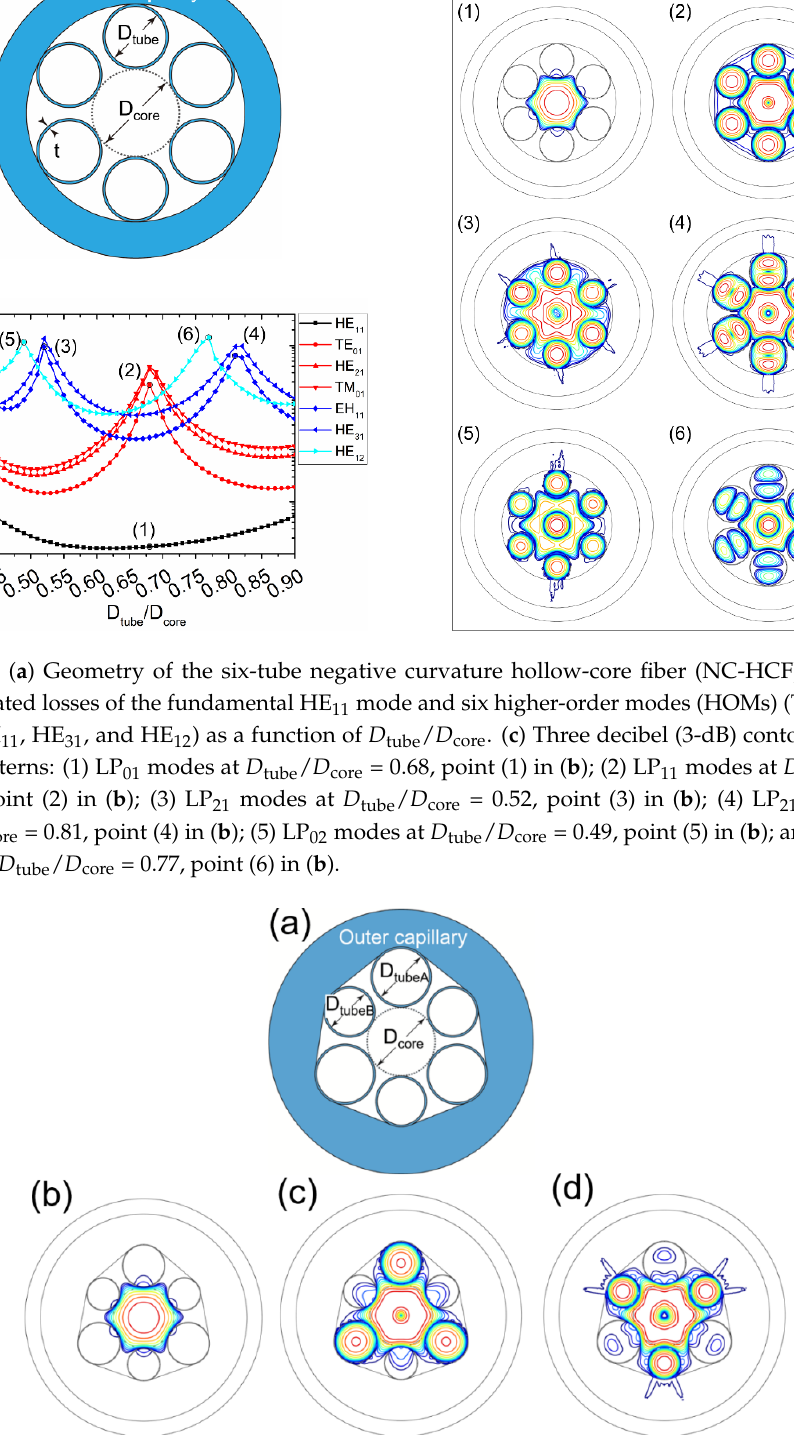
Figure 2. ( a ) Geometry of the hybrid NC-HCF with D tubeA = 0.68 D core and D tubeB = 0.52 D core . Three decibel (3-dB) contour lines of ( b ) LP 01 modes, ( c ) LP 11 modes, and ( d ) LP 21 modes of the hybrid NC-HCF. Note the similarity with the corresponding mode patters in the top row of Figure 1c. The losses and effective refractive indexes of the fiber for the two polarizations were